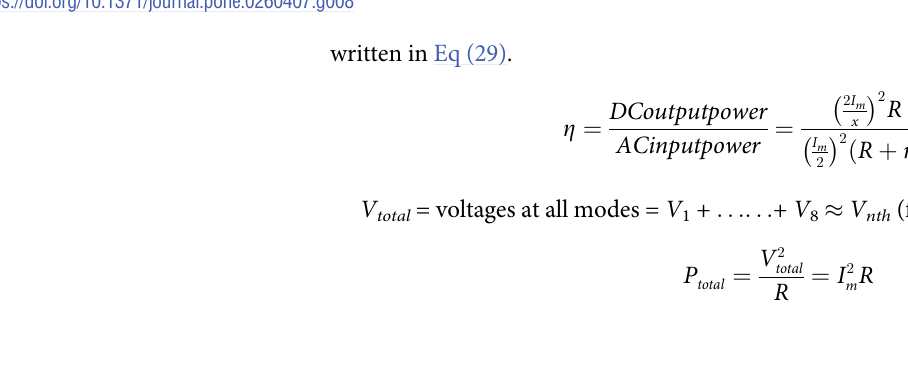
Table 6. Power harvested at different radiation modes.